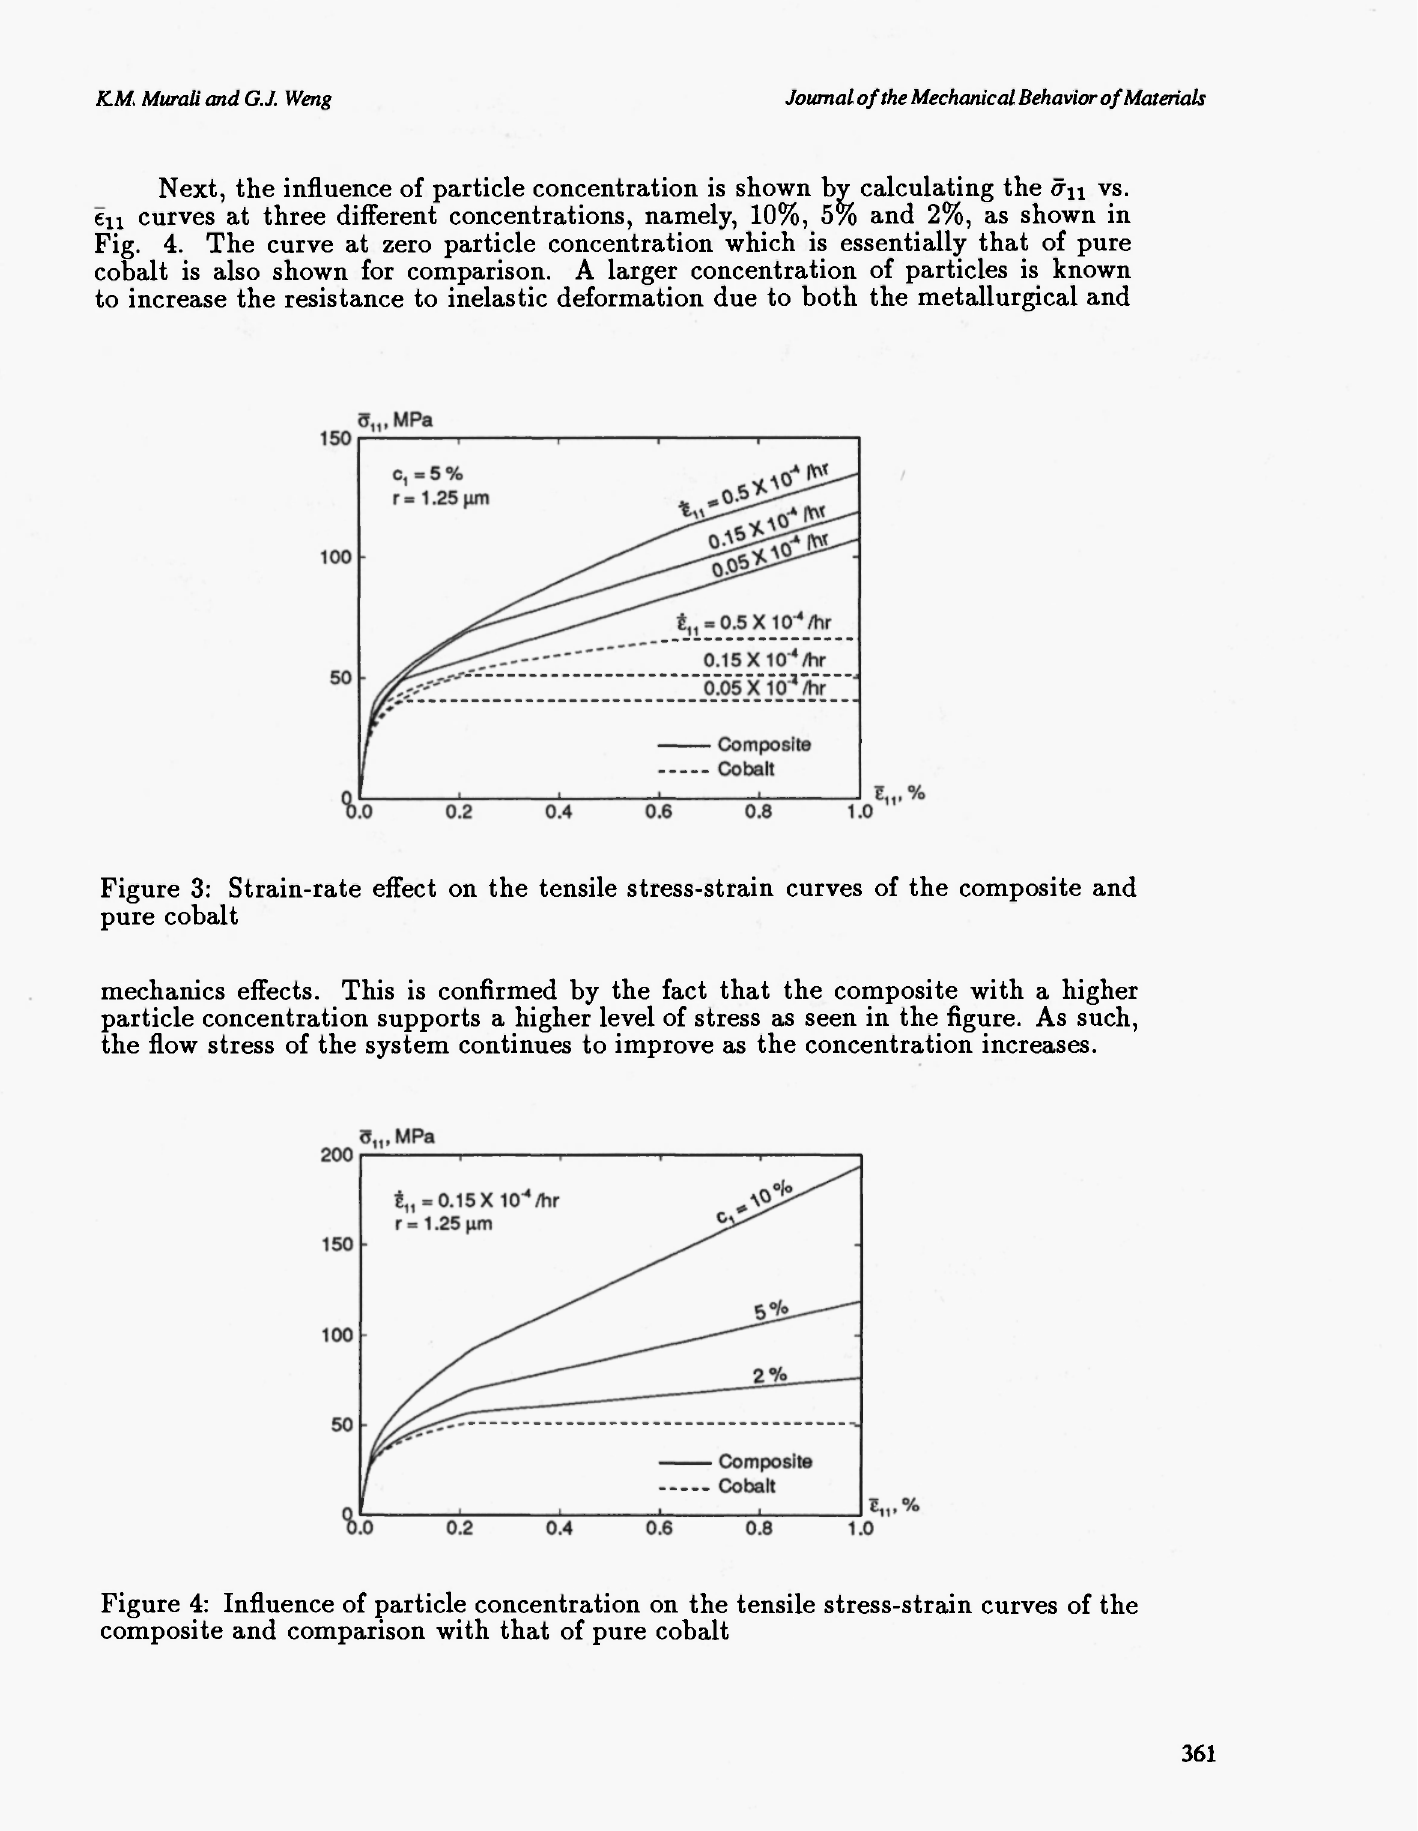
Figure 3: Strain-rate effect on the tensile stress-strain curves of the composite and pure cobalt